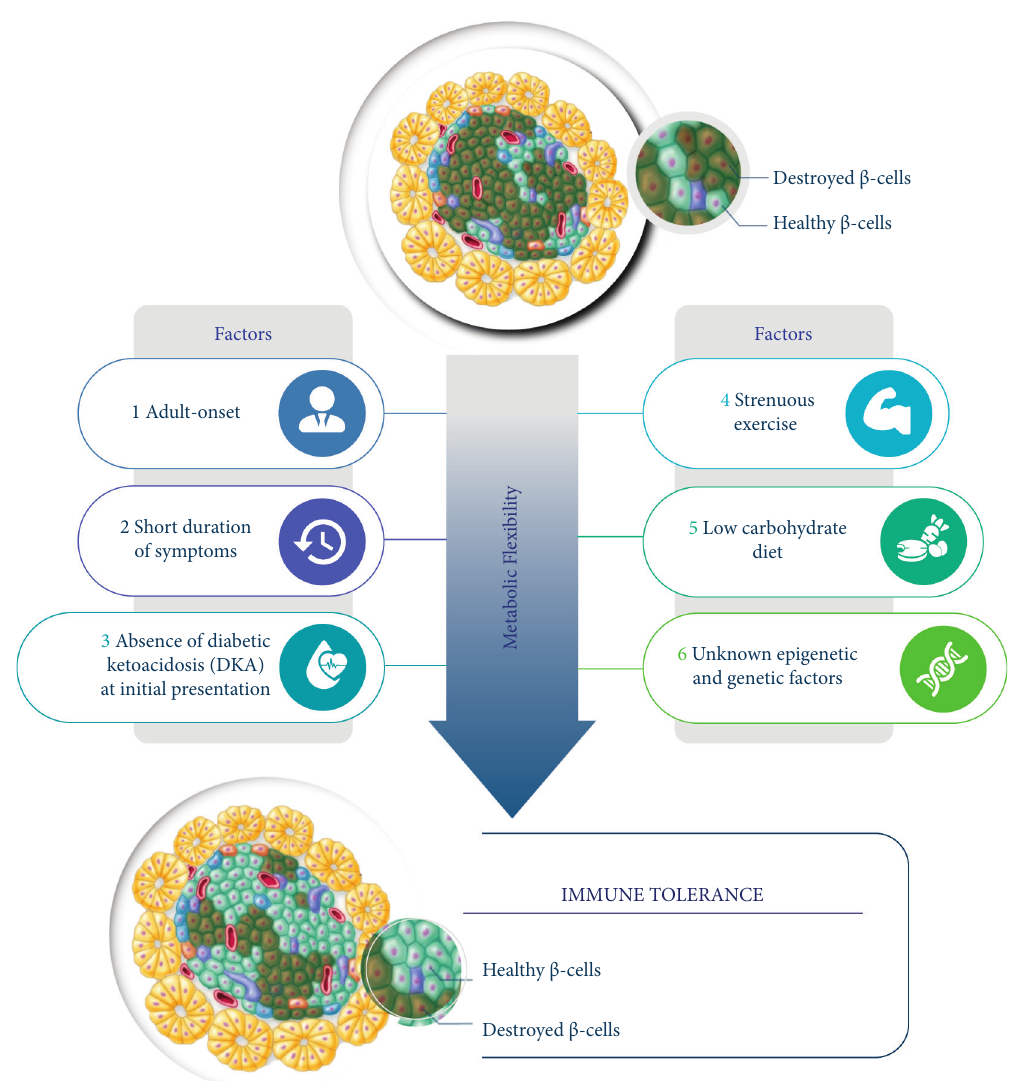
Figure 3: Postulated mechanisms of prolonged honeymoon period in this patient.